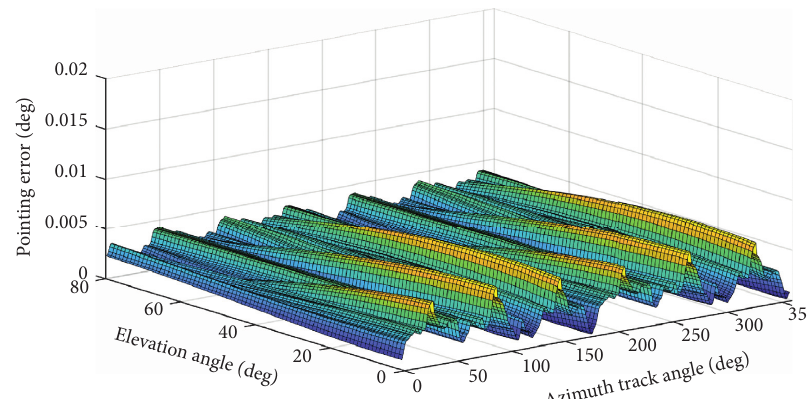
Figure 12: Telescope pointing error for the six-support-point case.